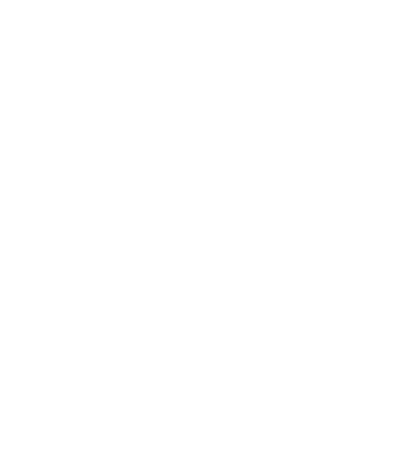
Figure 6. XRD patterns of the egg-shell-type 3.5 wt% Ni/MgAl 2 O 4 pellet catalysts after reduction.